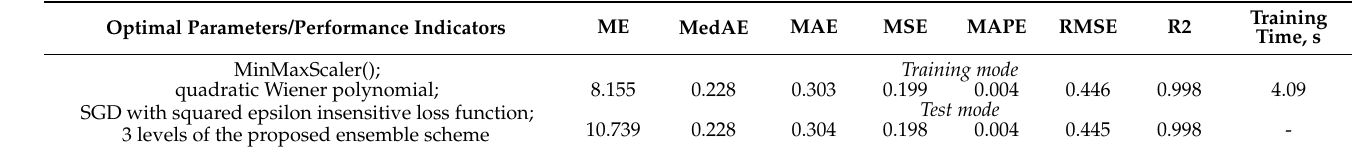
Table 5. Performance indicators for the proposed ensemble scheme with optimal parameters.